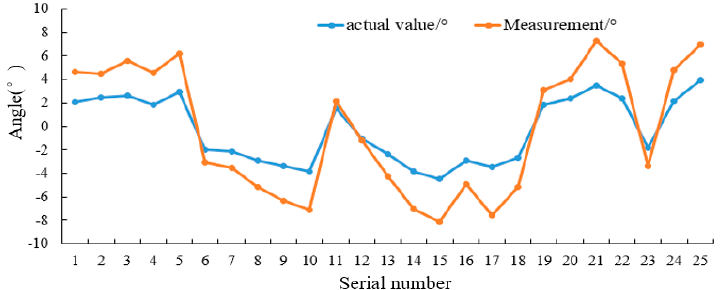
Figure 13. The field test result.